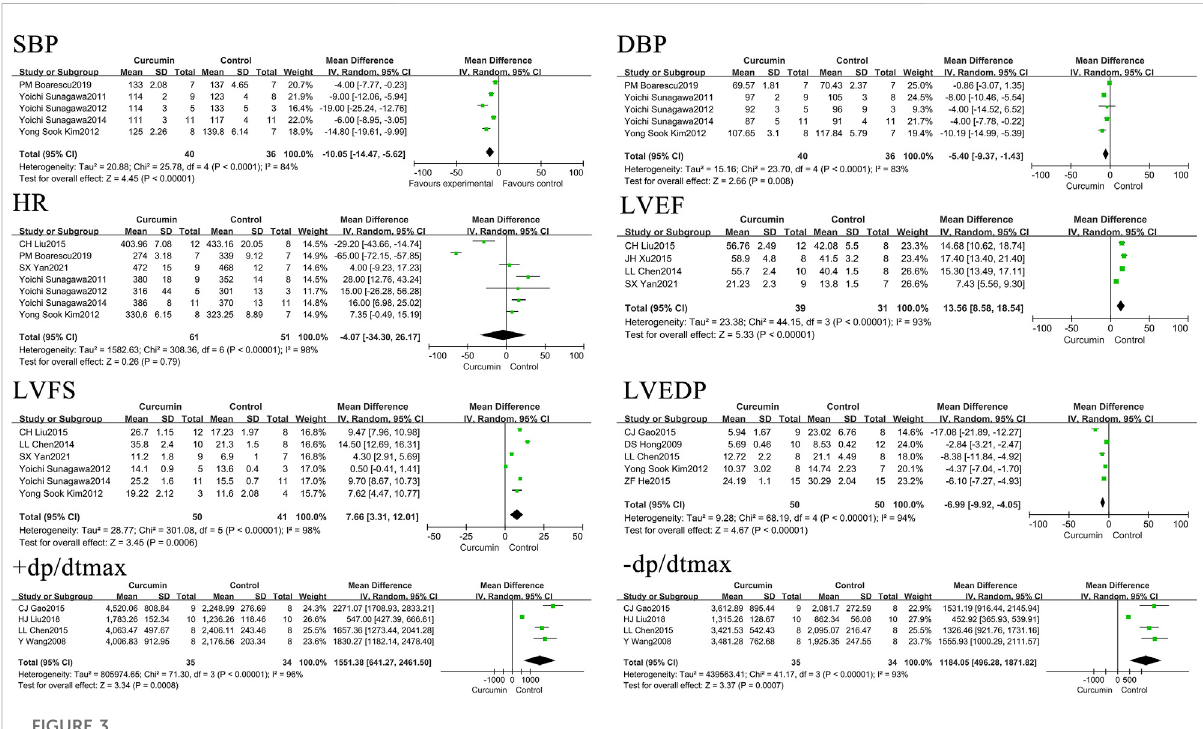
Forest plot of hemodynamic related indicators: SBP, DBP, HR, LVEF, LVFS, LVEDP, +dp/dtmax, -